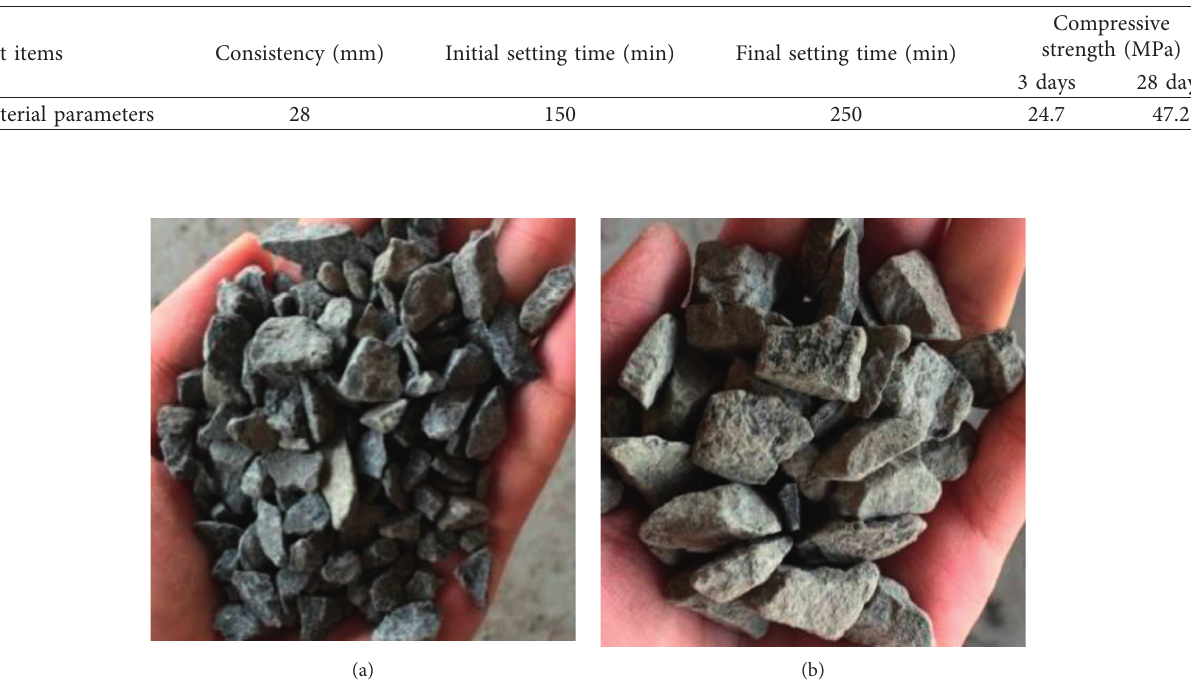
Table 1: Cement quality